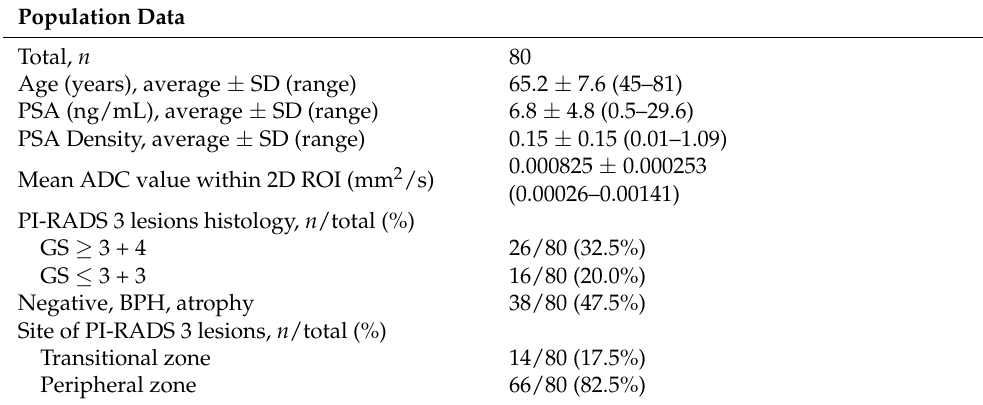
Table 1. Characteristics of the final study population.